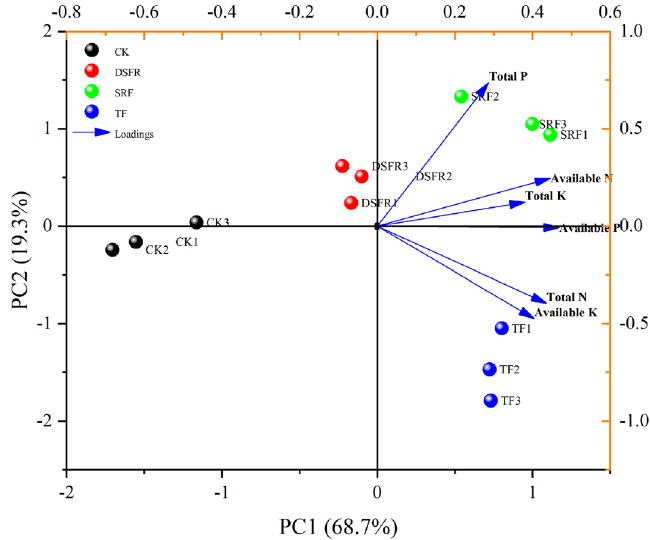
Figure 8. Principal component analysis (PCA) of different fertilization treatments and soil nutrients, including PCA score scatter plot and PCA loading plot.